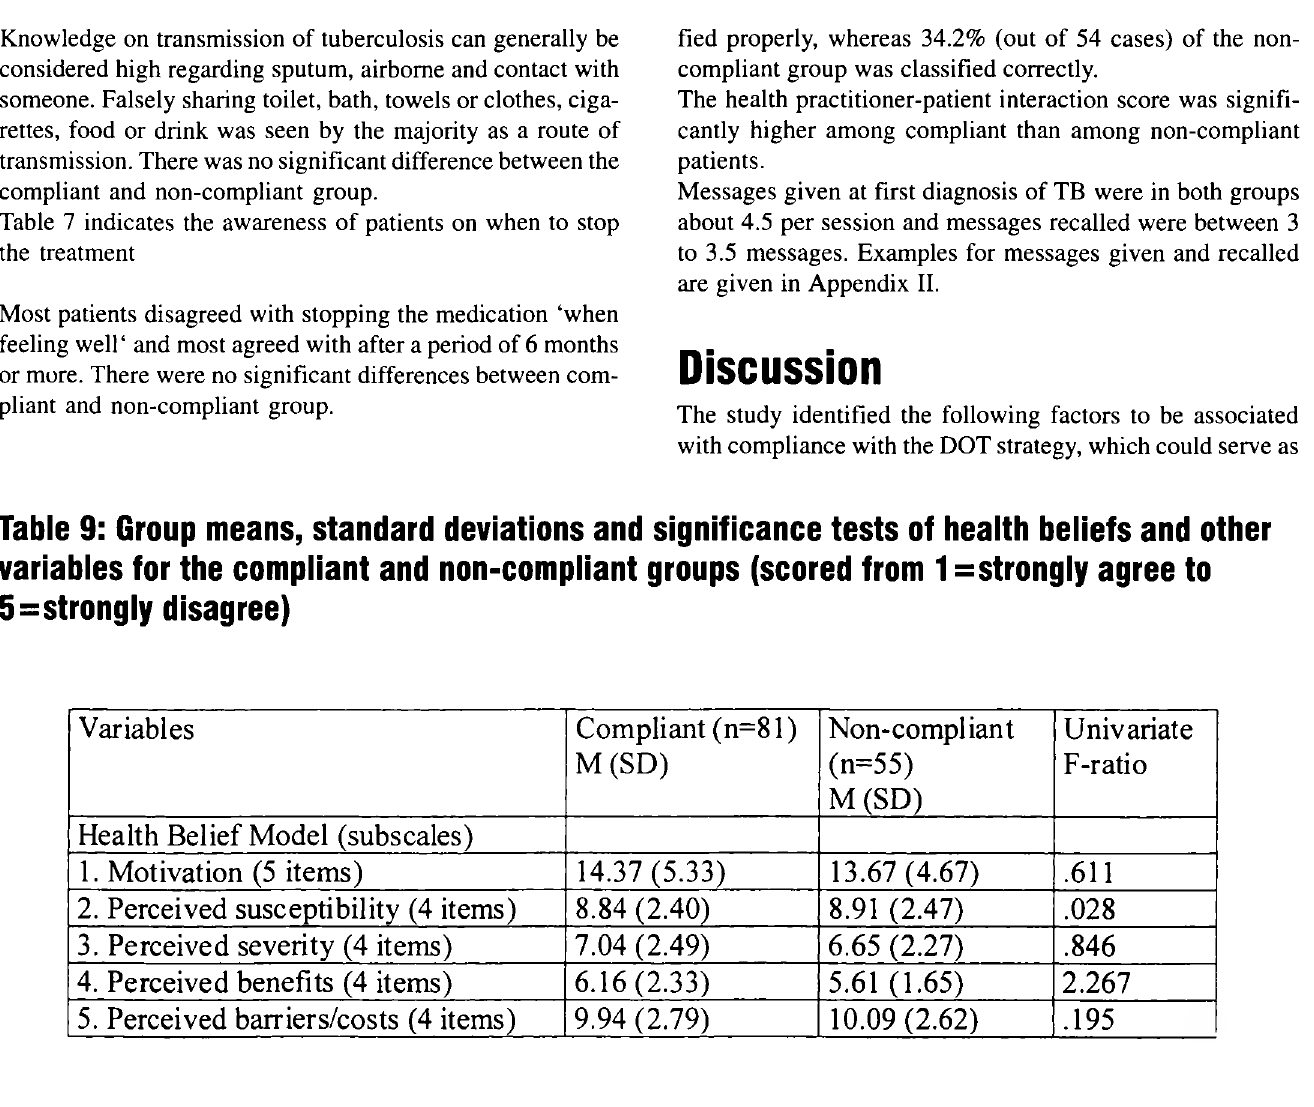
Table 8 indicates substance use and family and community history of tuberculosis of the participants.